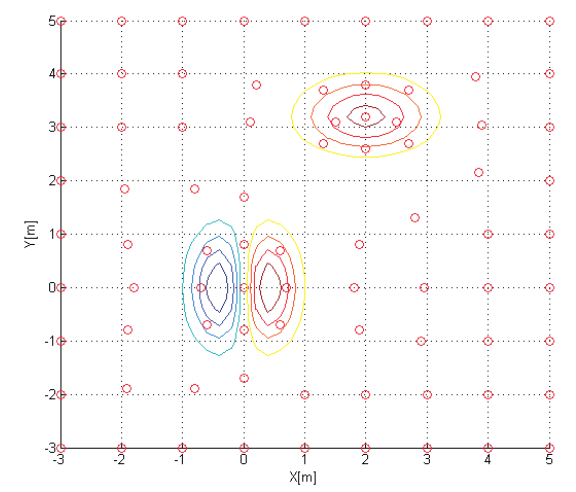
Figure 9. Updated sensor node location.